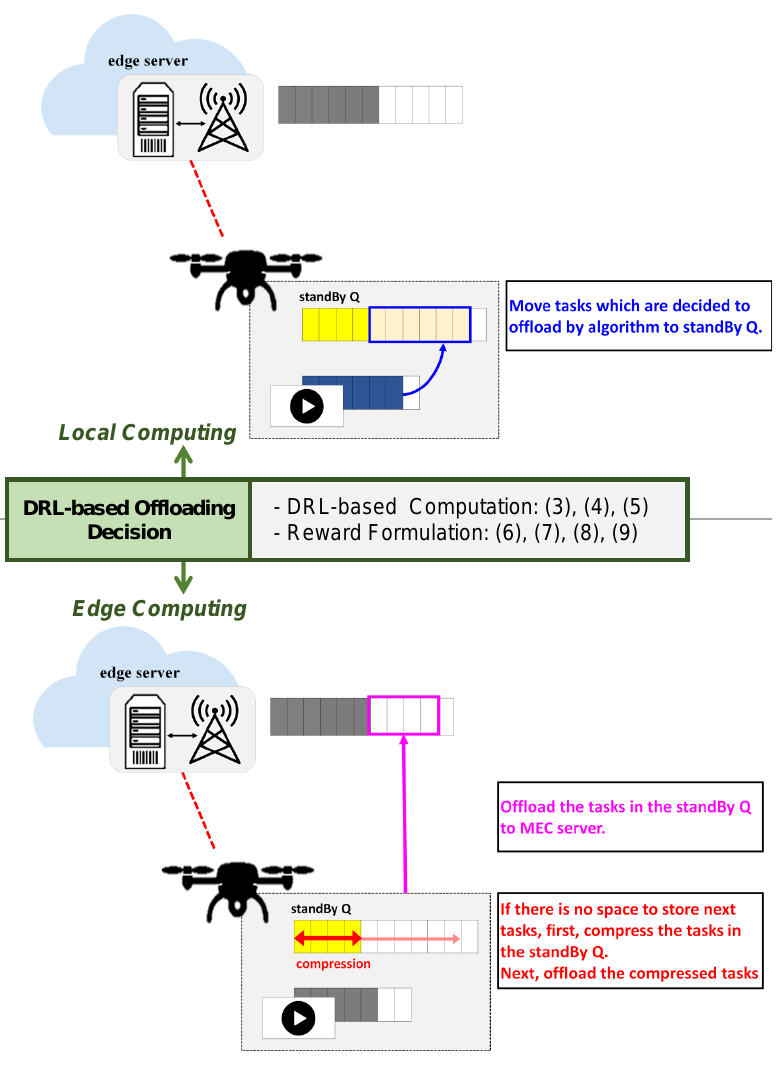
Figure 3. Execution process for the proposed DQN-based novel offloading compression decision